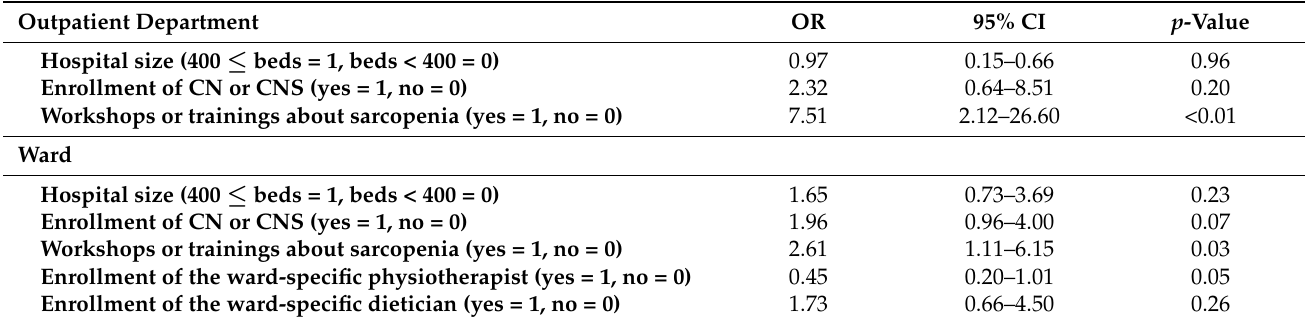
Table 3. Multivariate logistic regression analysis for